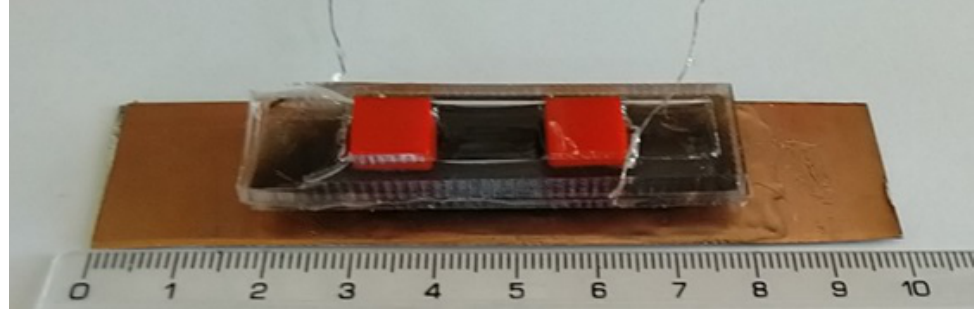
glued to an elastic substrate (sticlotextolite), as presented in Figure 5, which is used only for a guiding role in the 3- point bending piezoresistive tests.